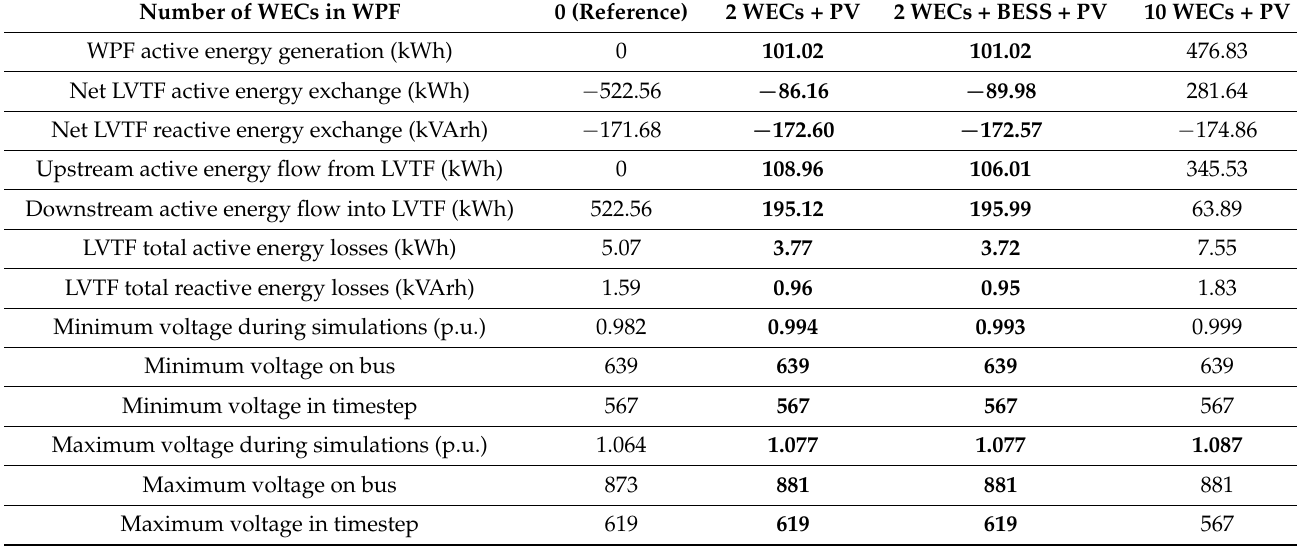
Table 8. Results of the daily operation simulation for case study